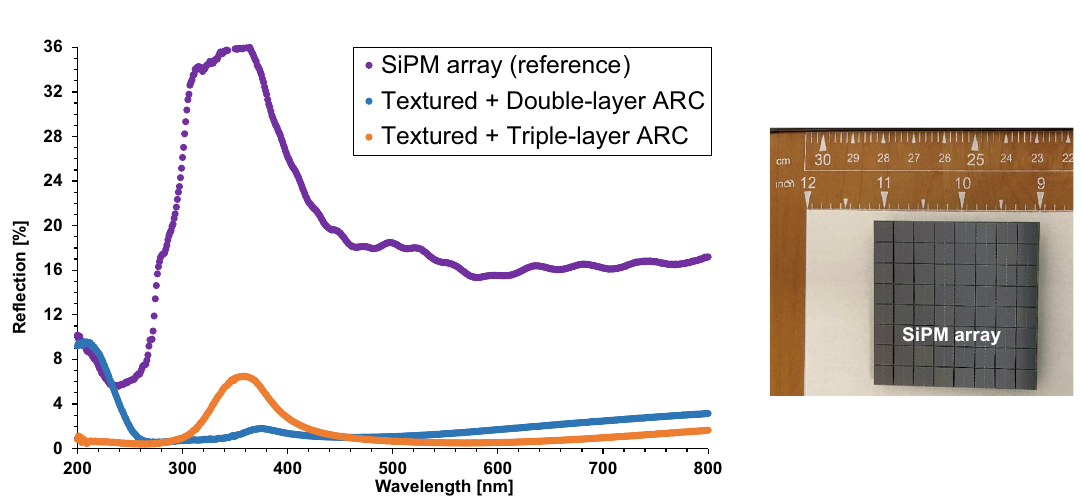
Figure 8. Reflection comparison of multi-layer ARC and commercial SiPM array as a reference. The photo of SiPM array is